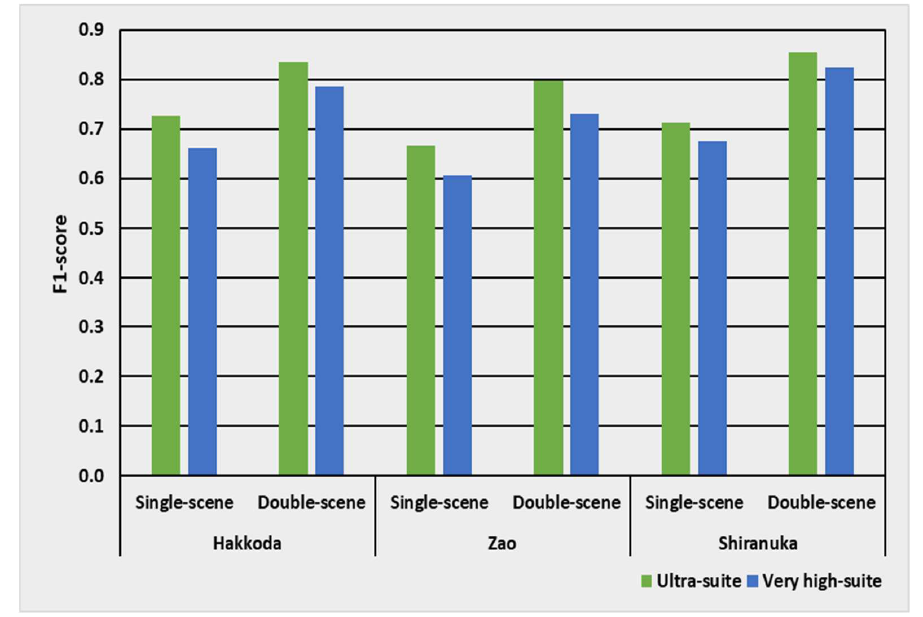
Figure 15. Overall performance summary.